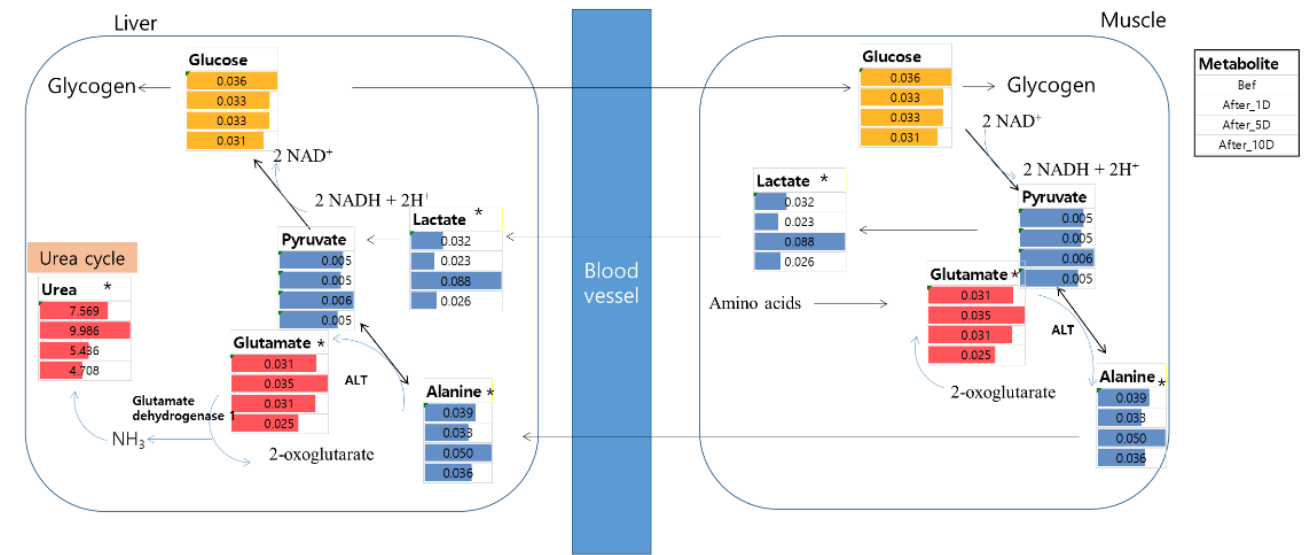
Figure 4. Metabolic change of potential biomarkers in the glucose-alanine cycle. * means signifi- cantly different metabolite compared to before WTS. Bef: before WTS; After_1D: 1 day after WTS; After_5D: 5 days after WTS; After_10D: 10 days after WTS.